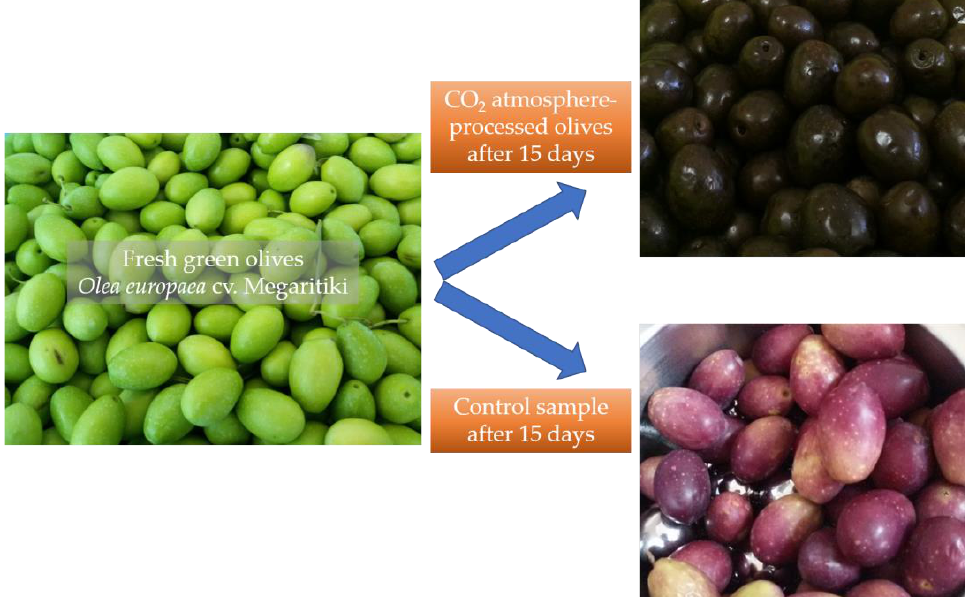
Figure 2 . Color changes of olives stored under CO 2 atmosphere and under regular atmospheric conditions (control), after 15 days.